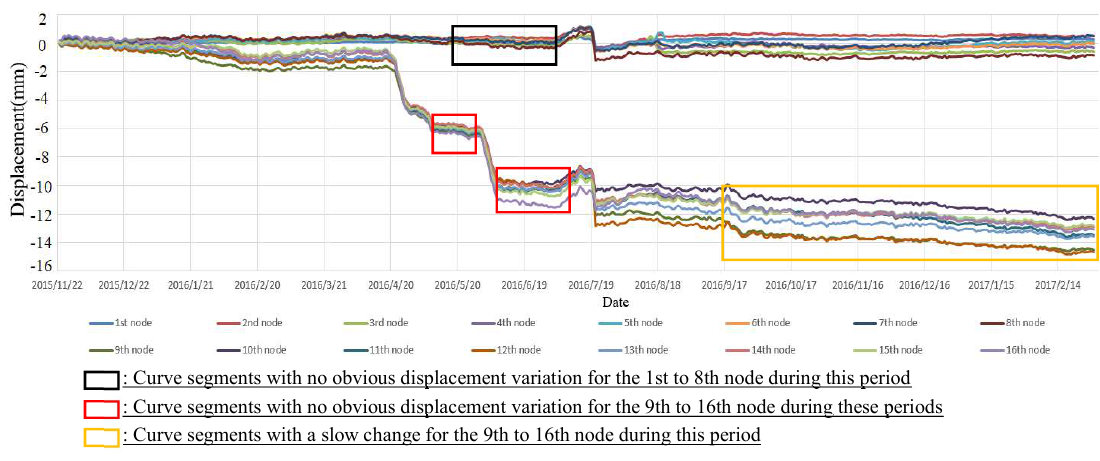
Figure 7. The cumulative horizontal displacement curve of the SAA in the Z direction of the 8 m-long SAA.